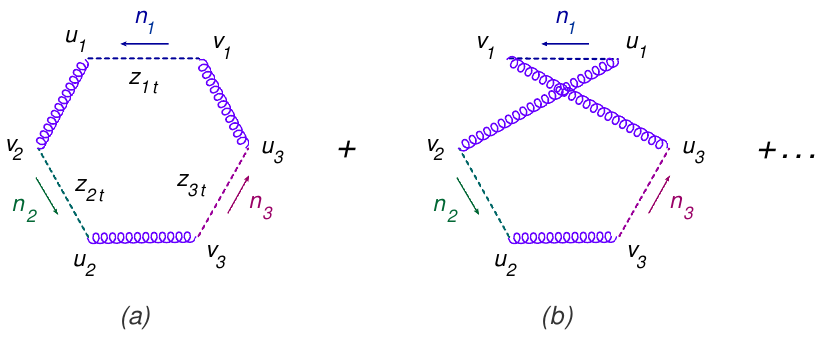
Figure 16 . Tree-level correlator of three twist-two gluon LR